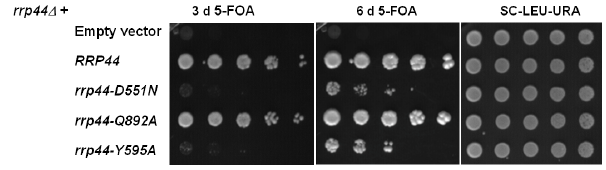
Figure 3. The Y595 residue is important for exosome function. A rrp44 D strain complemented by full-length RRP44 on a plasmid with a URA3 marker was transformed with LEU2 plasmids encoding each of the mutations. Growth on 5-fluoroorotic acid (5FOA) indicates that rrp44- Q892A can carry out the essential function of the exosome. Mutation to alanine of the tyrosine 595 residue reduces growth.